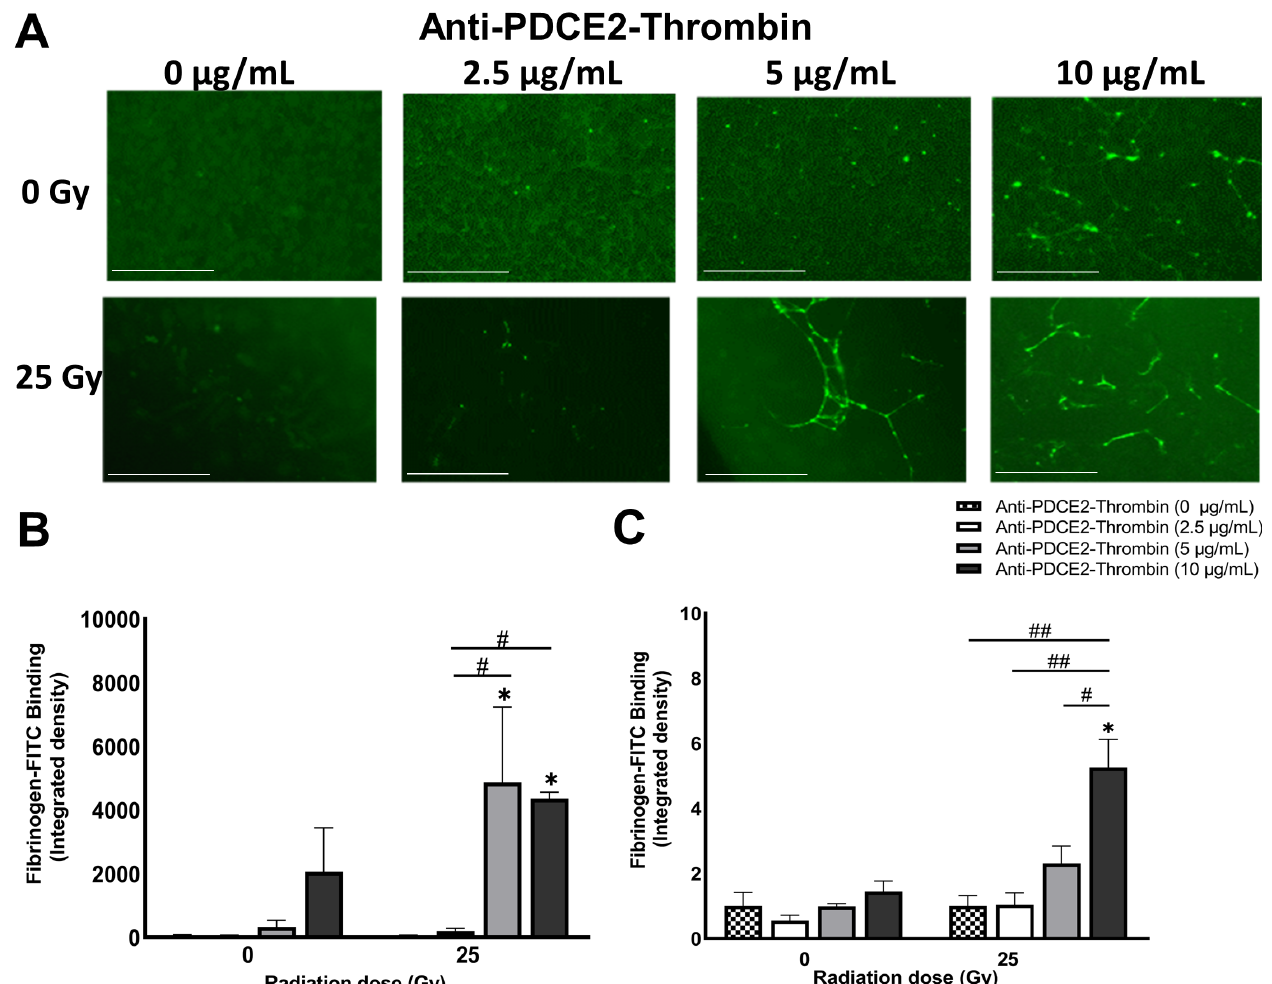
Figure 6. High throughout, static approaches for assessment of fibrin deposition demonstrate lower sensitivity (static multi-well model). ( A ) Representative fluorescent images of a 96-well microplate demonstrating extent of fibrin clot deposition (FITC, green) 2 days after irradiation (25 Gy only) in the presence of anti-PDCE2-thrombin coaguligand (0–10 µ g/mL) and 200 µ L whole human blood for 10 min. Images were captured using an EVOS Imaging System. Magnification, 100 × (Bar = 400 µ m). ( B ) FITC fluorescence (integrated density) in fluorescent images was analyzed using NIH Image J. ( C ) FITC-labelled fibrinogen binding was assessed in the same plates using a fluorescent microplate reader. For both analyses, average value of triplicate wells per individual treatment group is shown ± SEM (one independent experiment). Data were analyzed using two-way ANOVA with Tukey’s post-hoc analysis. * p < 0.5, comparison relative to non-irradiated, saline-treated cells (no coaguligand). # p < 0.05, ## p < 0.01, comparison within radiation